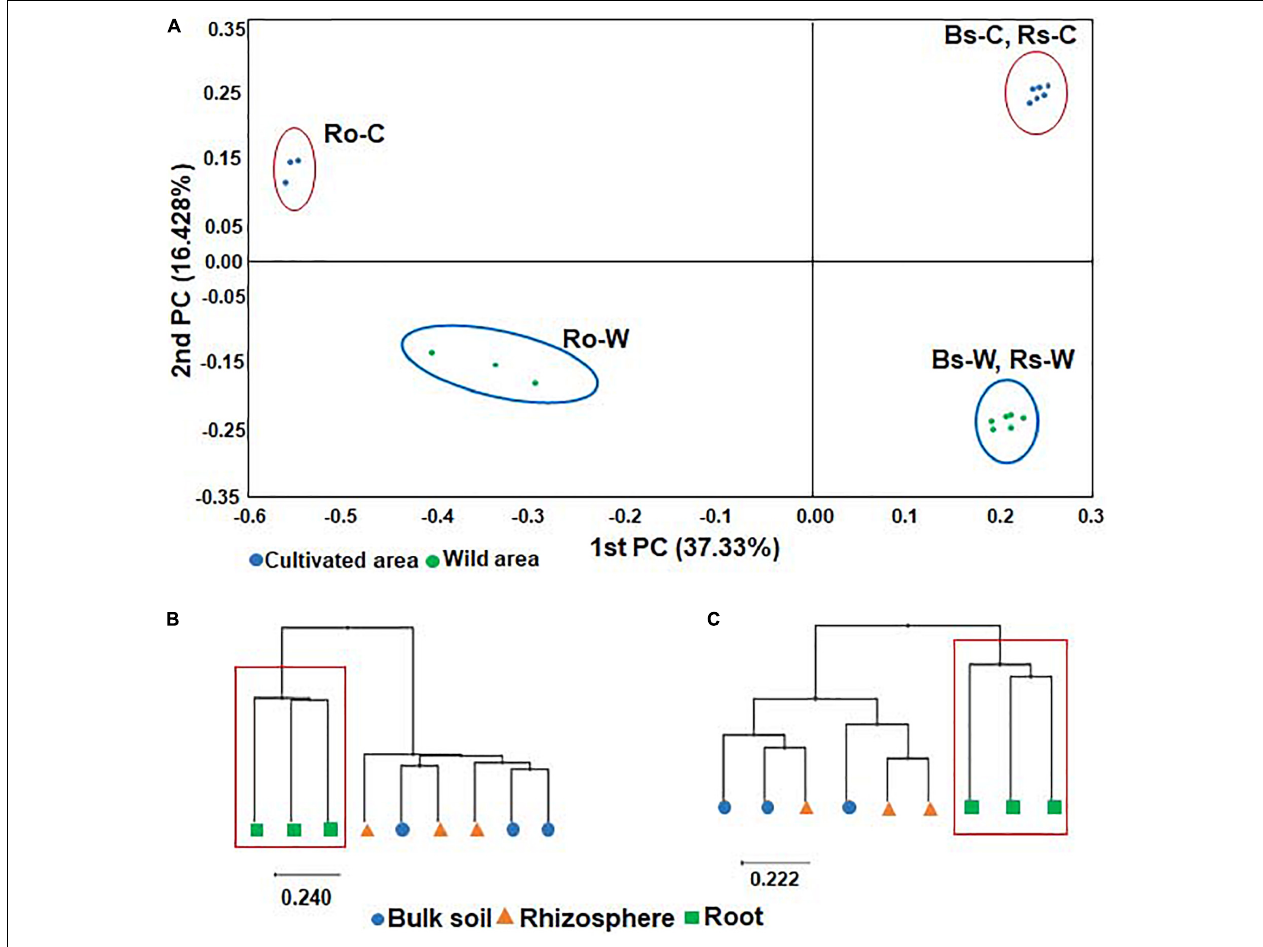
FIGURE 2 | Principal coordinates analysis (PCoA) of bacterial microbiota (A) and UPGMA clustering based on Bray-Curtis dissimilarity in (B) wild and (C) cultivated areas using relative abundance of all OTUs. The red box shows the cluster formed exclusively in roots of both wild and cultivated